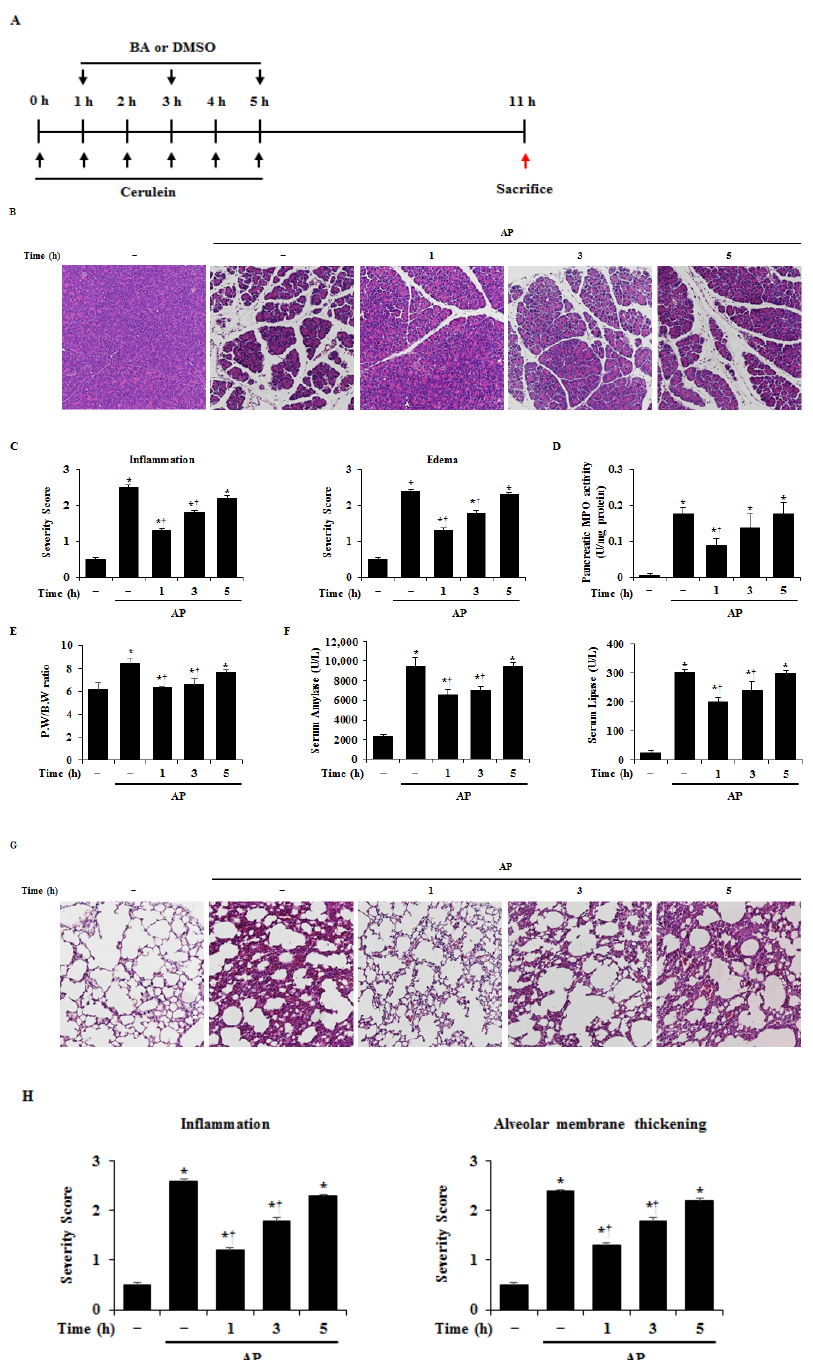
Figure 6. Therapeutic effects of betulinic acid (BA) in cerulein-induced acute pancreatitis (AP). ( A ) BA (10 mg/kg) or dimethyl sulfoxide (DMSO) was administered at 1, 3, or 5 h after the first cerulein injection. Mice were sacrificed at 6 h after the last cerulein injection. Representative hematoxylin and eosin (H&E)-stained ( B ) pancreas and ( G ) lung tissue section (200× magnification). ( C ) Histological sections of the pancreas were scored from 0 (normal) to 3 (severe) for inflammation and edema. ( D ) Pancreatic myeloperoxidase (MPO) activity. ( E ) Pancreas weight/body weight (PW/BW) ratio. (F) Levels of serum amylase and lipase. ( H ) Histological sections of lung tissue were scored from 0 (normal) to 3 (severe) for inflammation and alveolar membrane thickening. Data are represented as mean ± SEM for six mice in each group. Results are representative of three experiments. * p < 0.05 vs. DMSO treatment alone. † p < 0.05 vs. cerulein treatment alone.